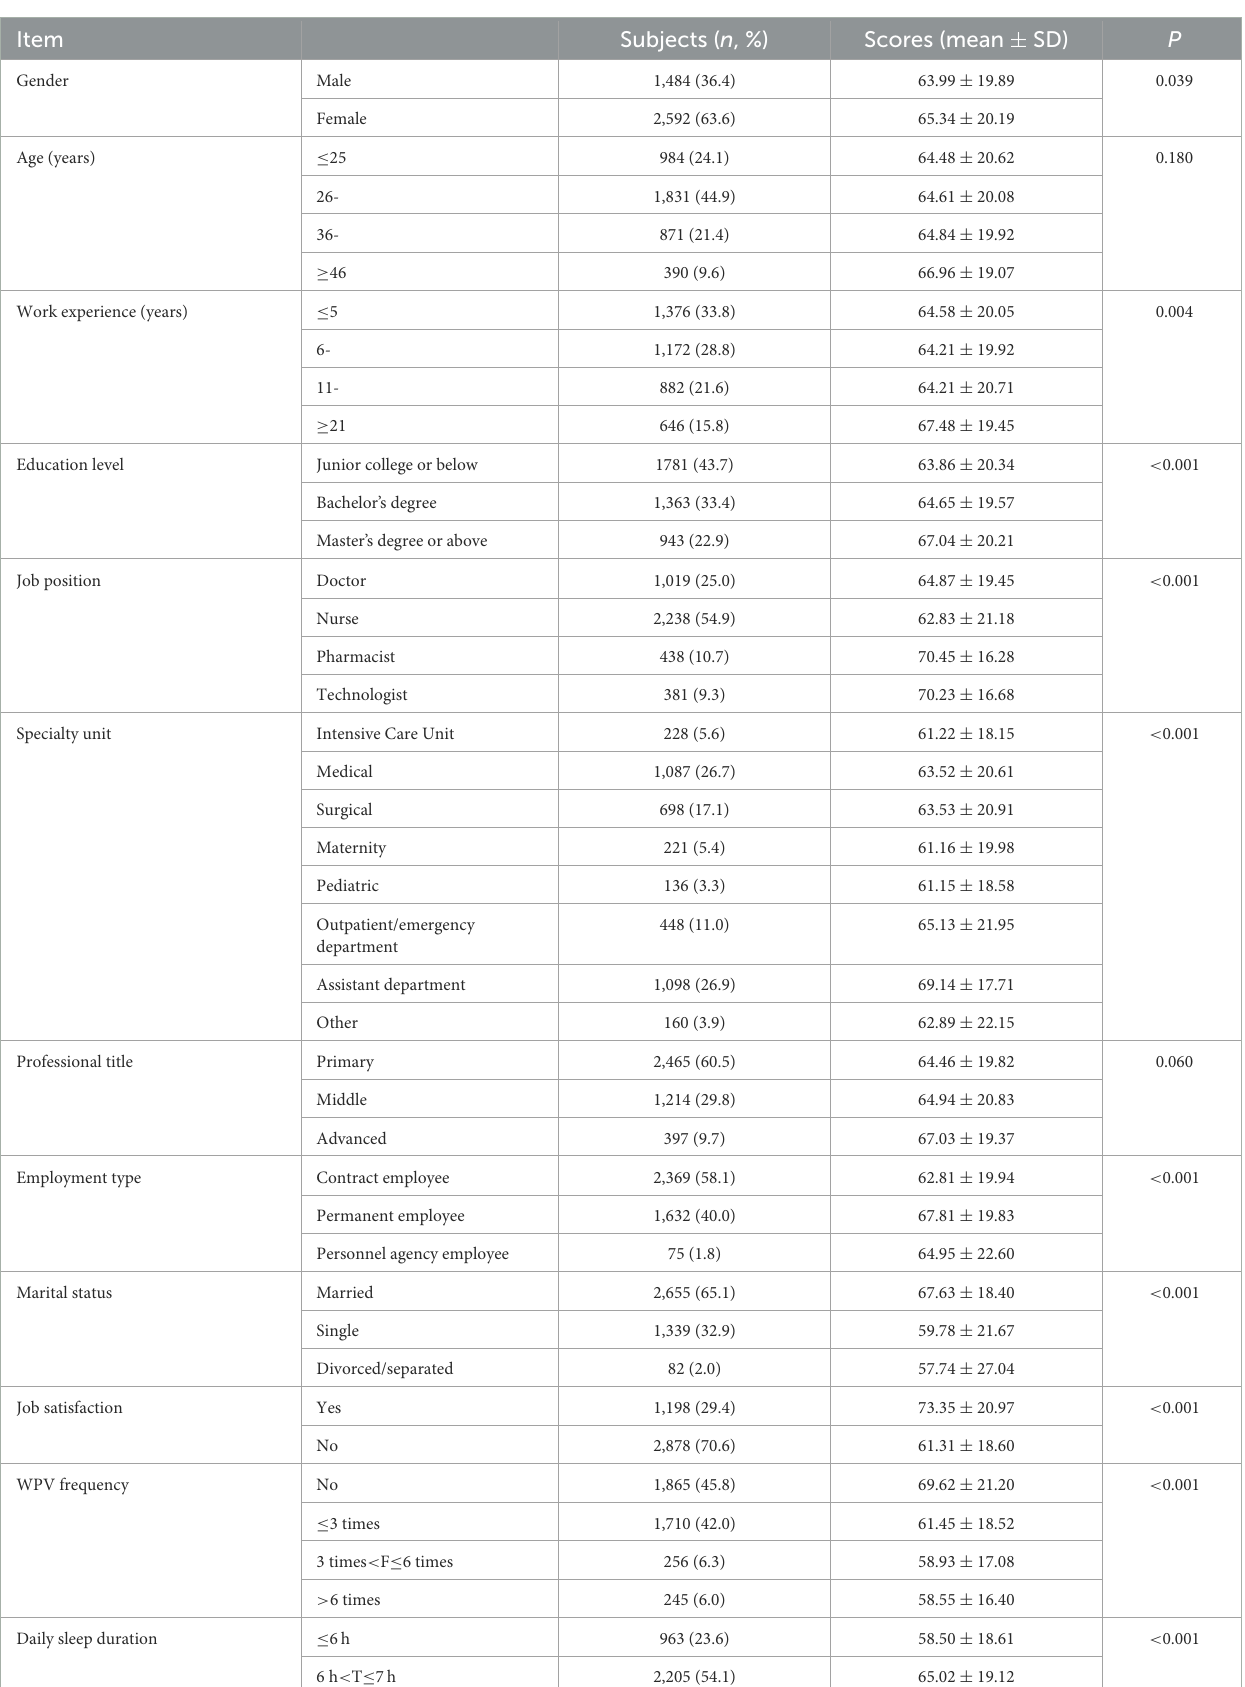
TABLE 1 General information on medical personnel ( n =